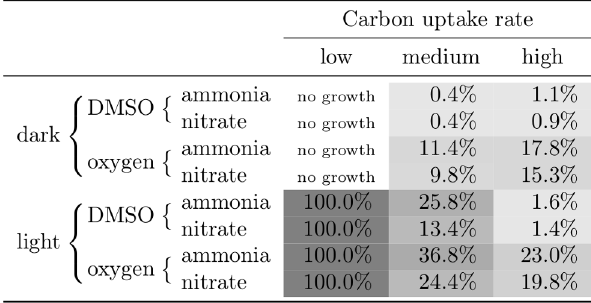
Figure 6. Relative contribution of the DMSP demethylation pathway in dependence of varying simulation parameters. The percentage and the background color indicate the maximal fraction of demethylated DMSP determined by flux variability analysis while the remainder represents the DMSP degraded by the cleavage pathway. The maximal difference to the minimal contribution is 1.2%.